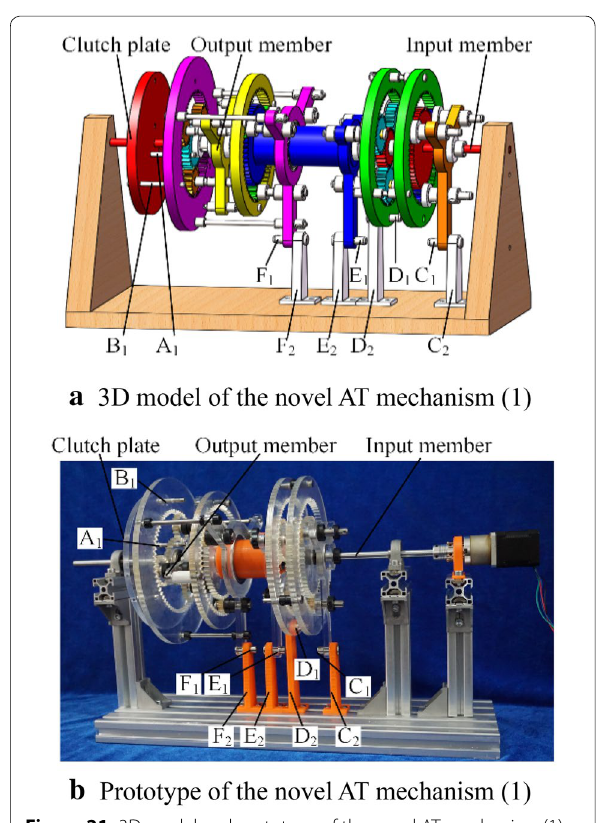
Figure 21 3D model and prototype of the novel AT mechanism